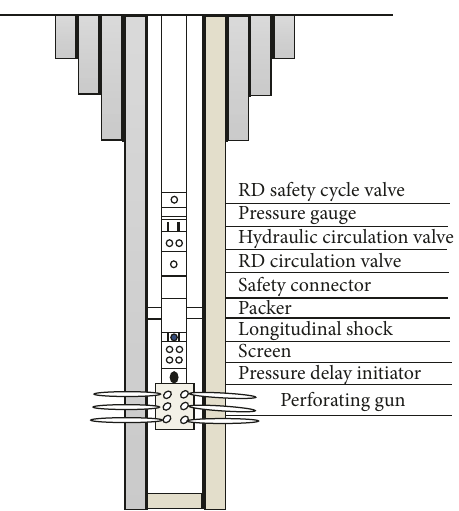
Figure 1: Downhole tools in perforation-test joint operation.